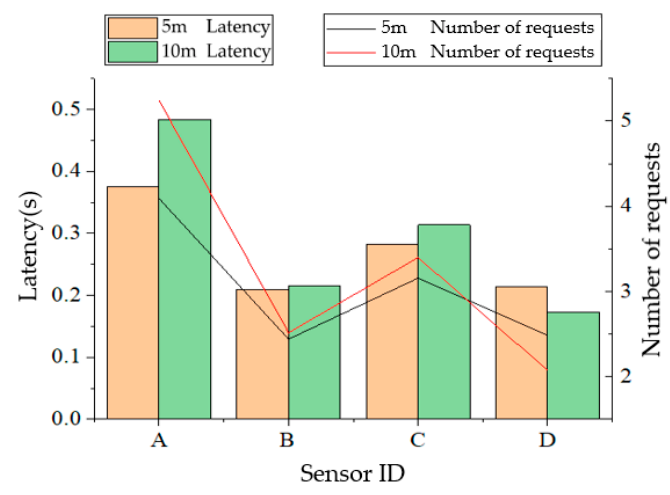
Figure 19. Average transmission latency of each node and average number of requests received.